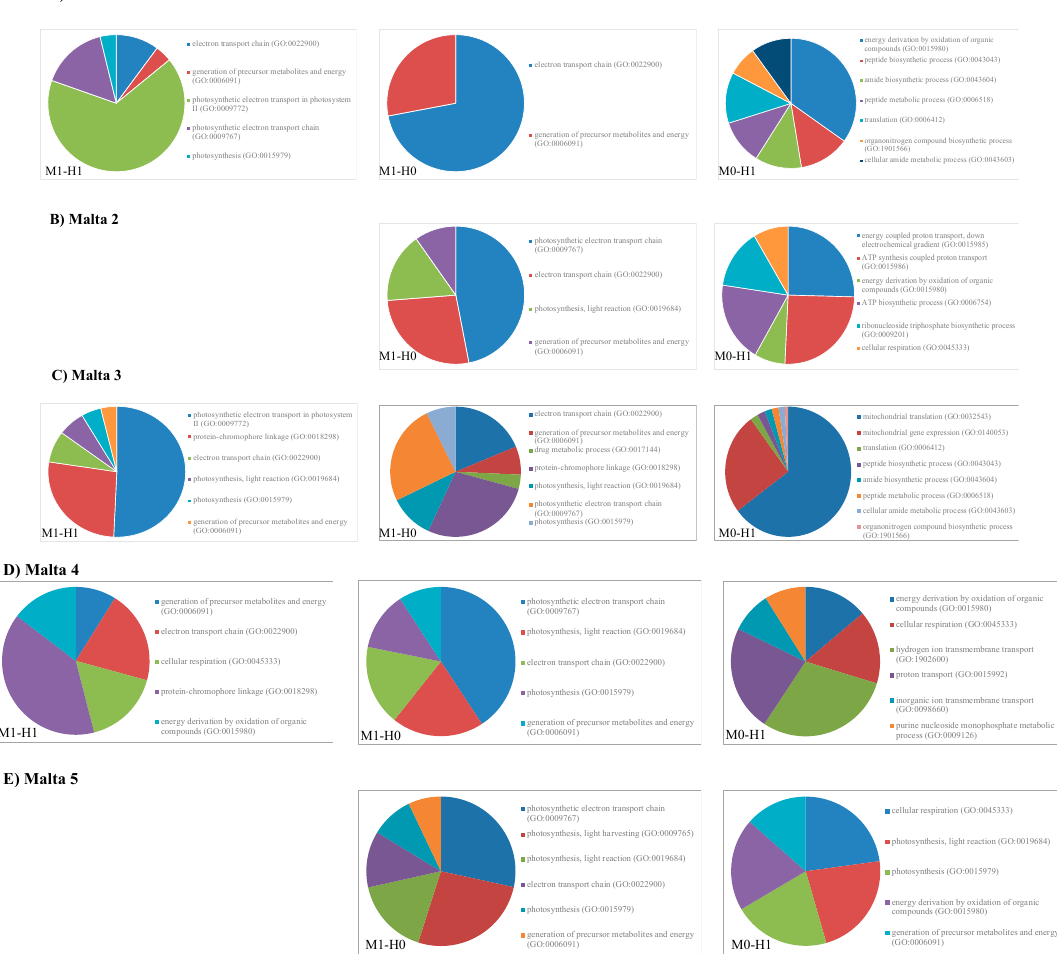
Figure 4. Biological processes a ff ected by the diverse DNA methylation status in Malta 1 ( A ), Malta 2 ( B ), Malta 3 ( C ), Malta 4 ( D ) and Malta 5 ( E